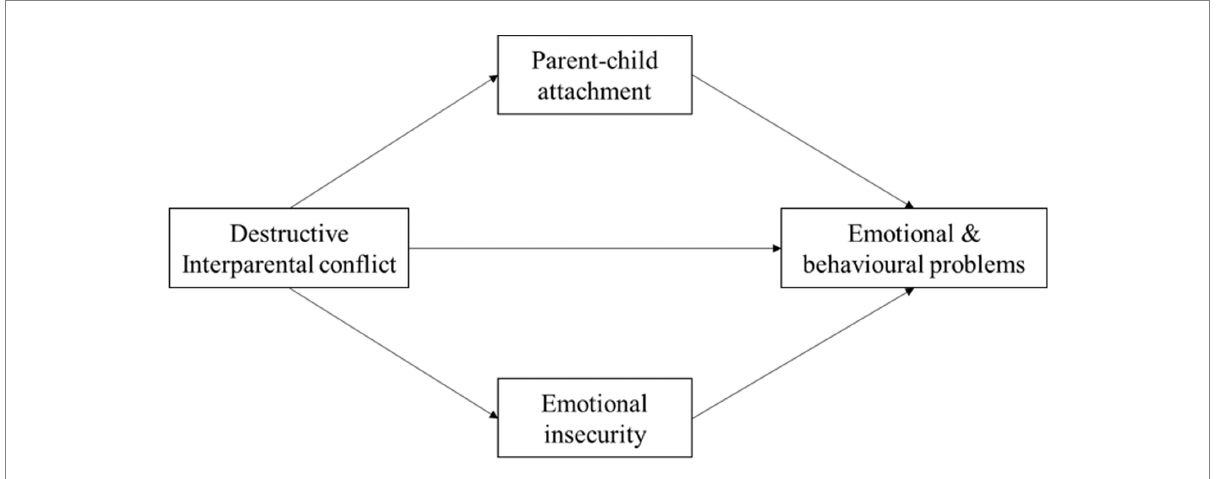
FIGURE 1 Hypothetical indirect pathways between destructive interparental conflict and adolescents’ emotional and behavioural